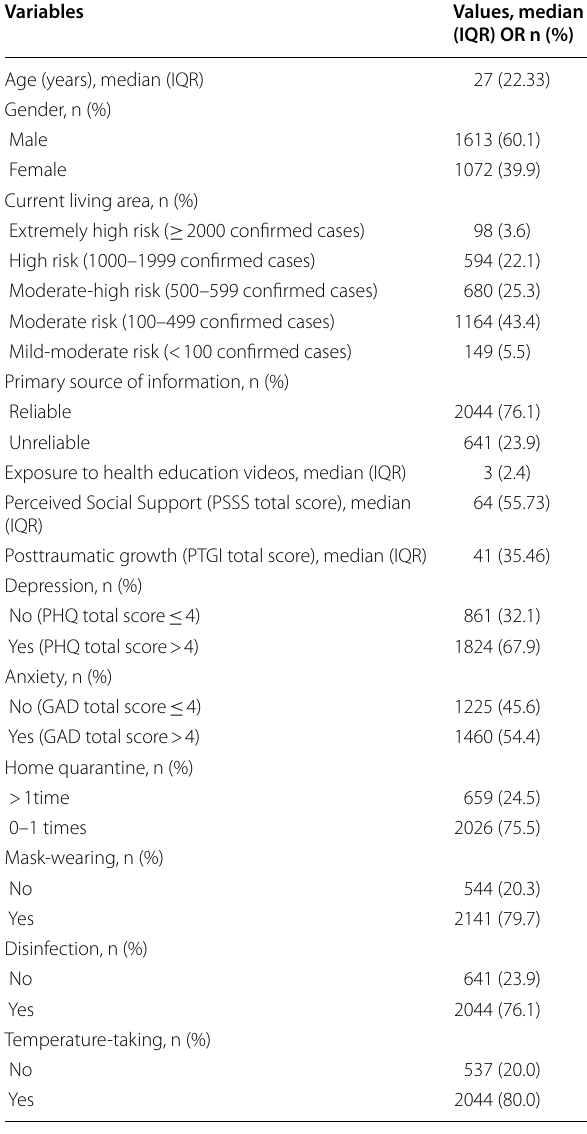
Table 1 Descriptive statistics for all variables (N